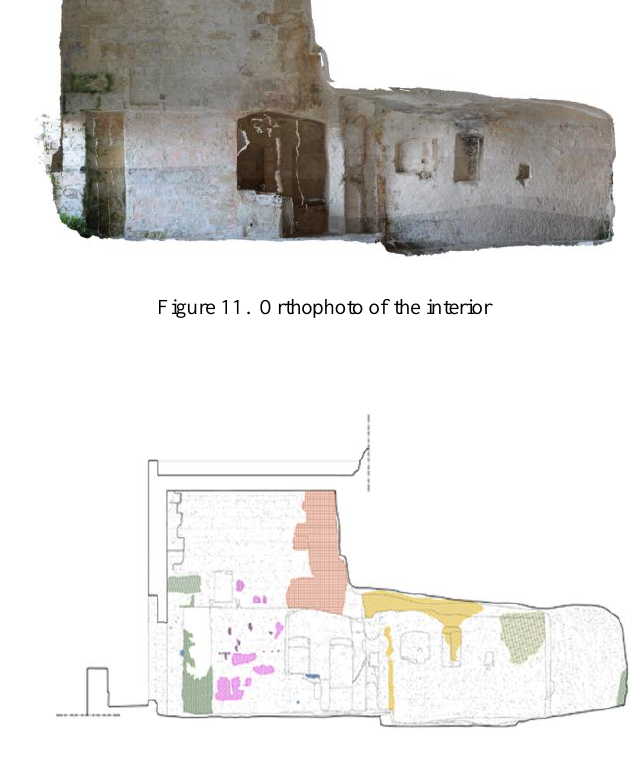
Figure 12. Degradations